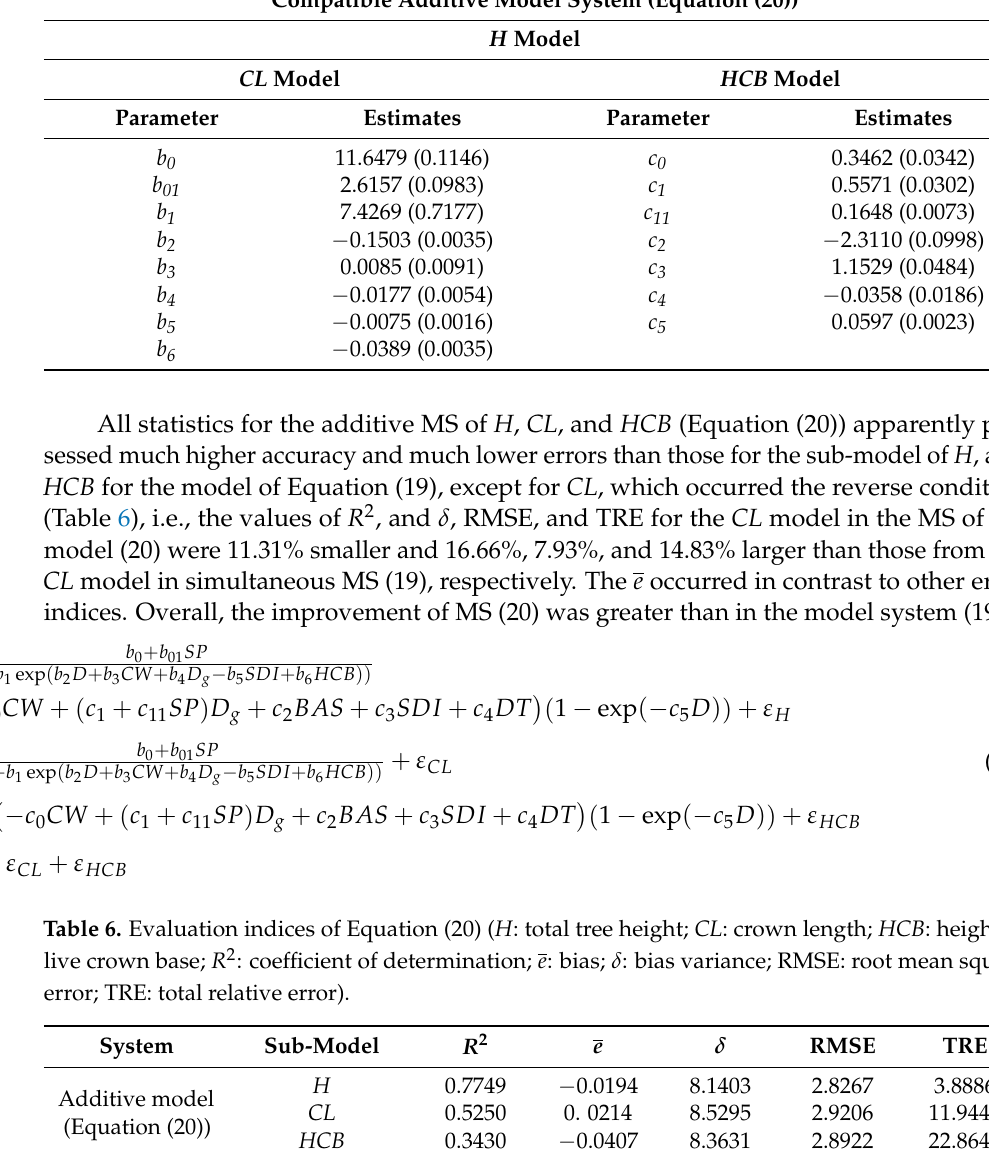
Table 5. Parameter estimates of the systems of H , CL , and HCB (Equation (20)) ( H : total tree height; CL : crown length; HCB : height to live crown base; values in the parenthesis are standard errors). Compatible Additive Model System (Equation (20)) H Model CL Model HCB Model Parameter Estimates Parameter Estimates b 0 11.6479 (0.1146)